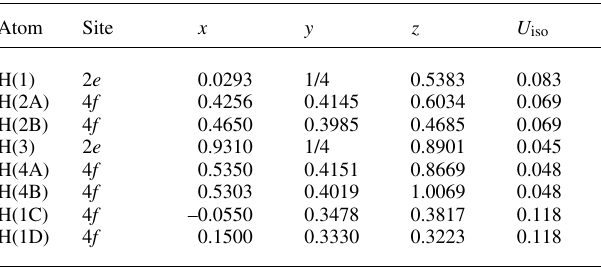
Table 2. Atomic coordinates and displacement parameters (in Å 2 )